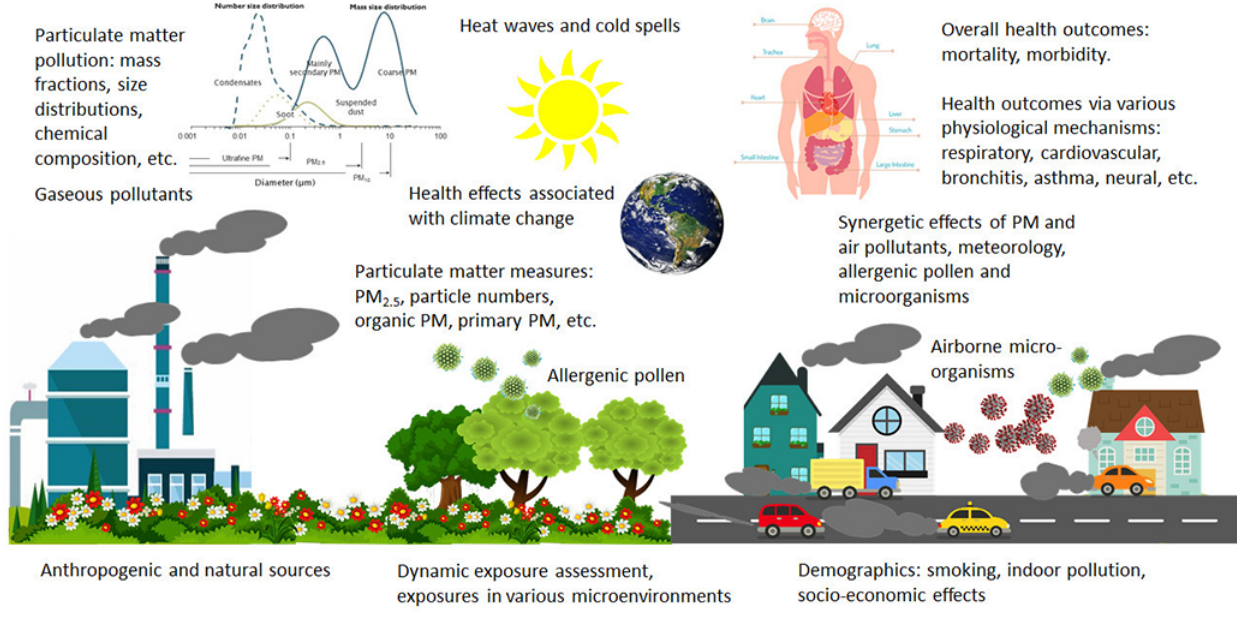
Figure 15. A schematic diagram that illustrates some of the main factors in the evaluation of the exposure and health impacts of particulate